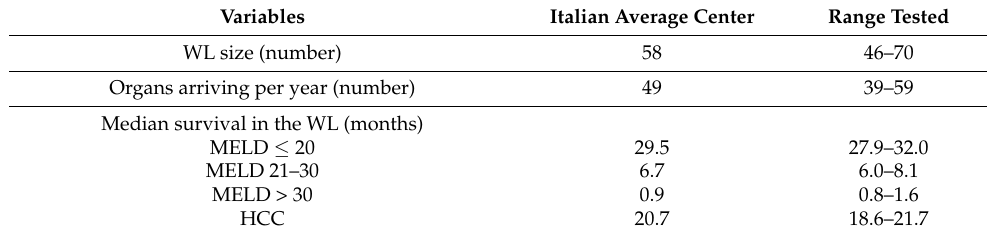
Figure 1. Ethical framework for describing the ethical tension between healthcare resources and individual transplant benefit in hepatocellular carcinoma (HCC) patients. The equipoise between individual and population needs is determined by the vector computation of individual transplant benefit (black) minus harm to others on the waiting list (brown). The individual transplant benefit is determined by the vector computation of individual post-LT survival (light blue) and mortality without transplant (green), while the harm to the others on the waiting list is determined by the vector computation of healthcare resources (i.e., % organs decrease, red) and population waiting list mortality (yellow). Abbreviations: LT, liver transplantation; WL, waiting list. Table 1. Variables utilized in constructing the Markov